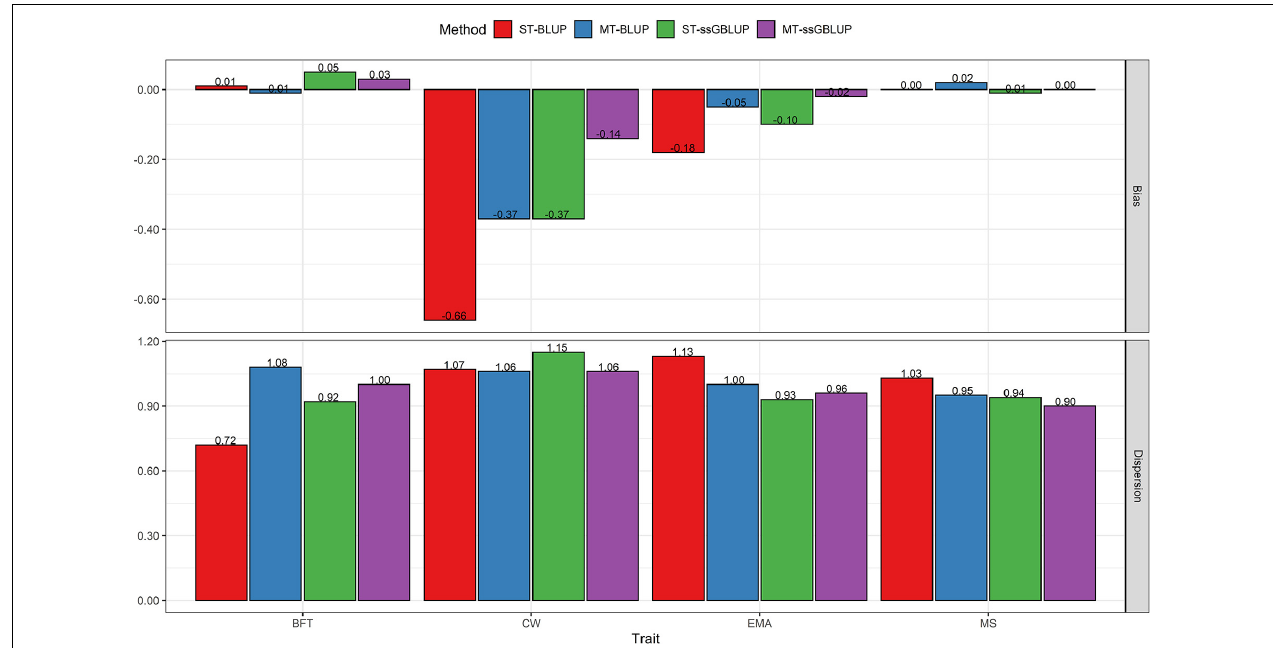
FIGURE 4 | Bias and Dispersion of breeding values obtained using BLUP (ST-BLUP, MT-BLUP) and ssGBLUP (ST-ssGBLUP, MT-ssGBLUP) models for steers at yearling date. ST and MT are single-trait and multi-trait analyses, respectively. BFT, backfat thickness; CW, carcass weight; EMA, eye muscle area; MS, marbling score; YW, yearling